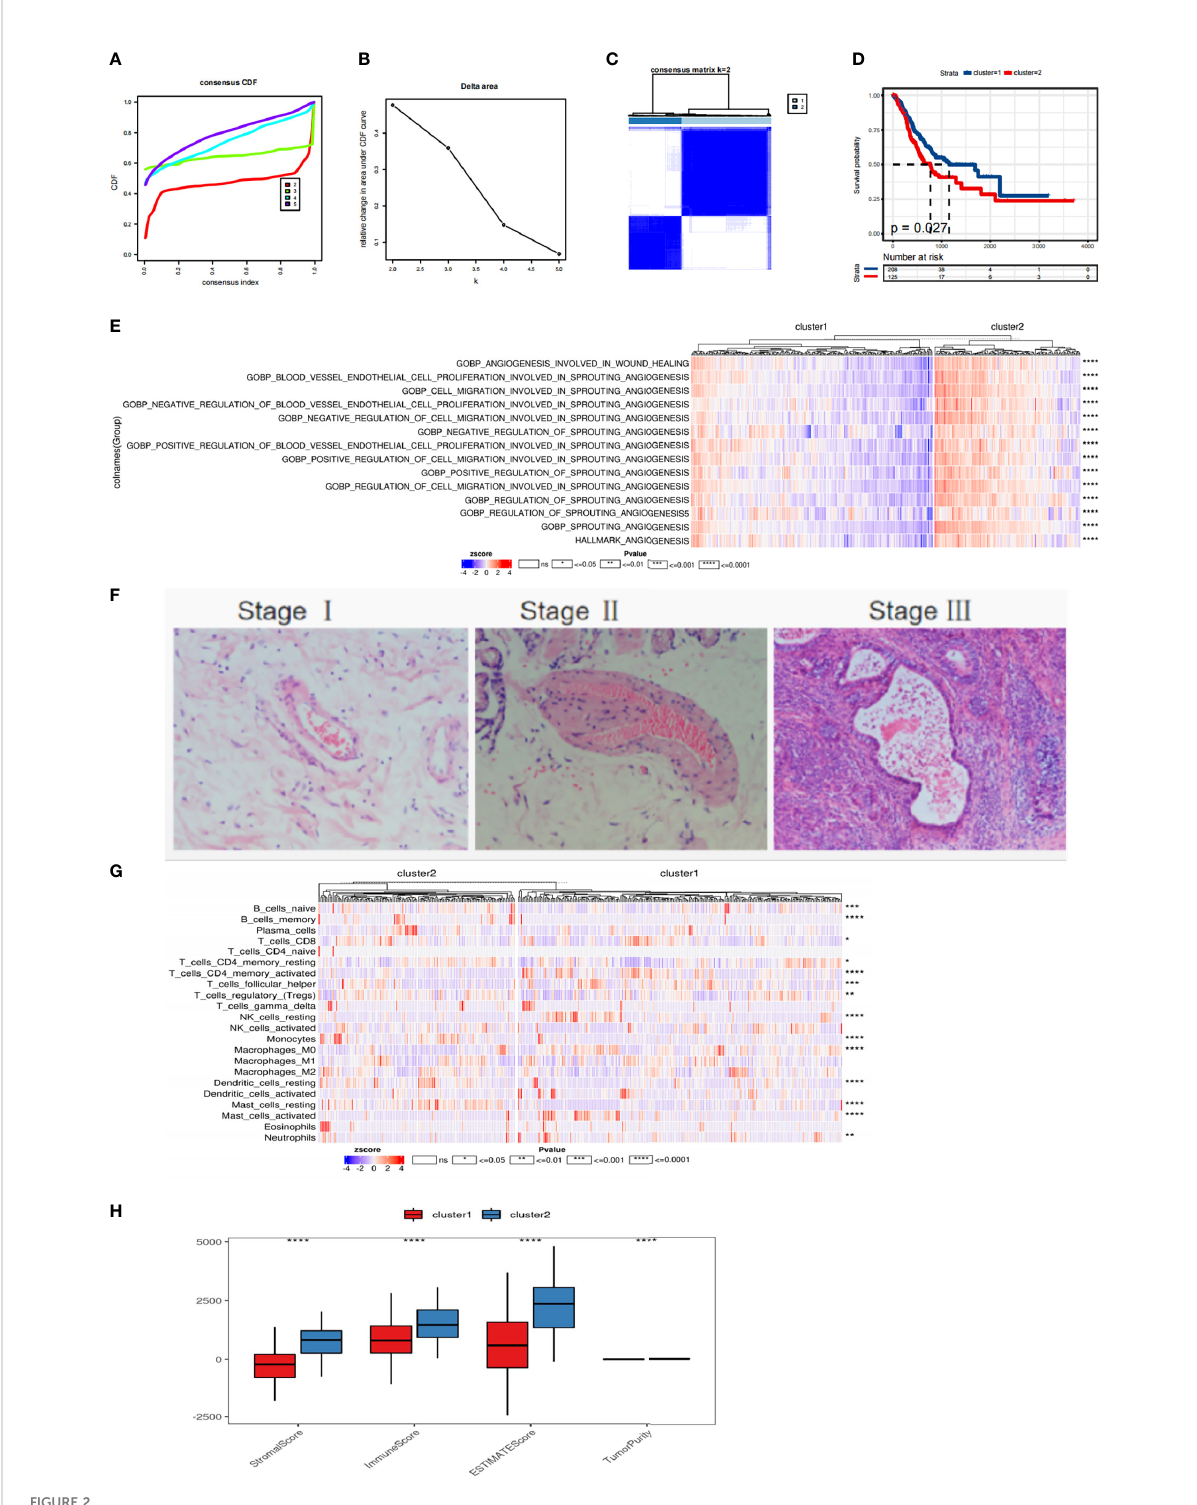
FIGURE 2 Molecular subtype recognition of fatty acid related genes (A, B) TCGA gastric cancer samples were analyzed by consistent cluster analysis based on 78 fatty acid related genes. (C) The consistency matrix heat map when the number of clusters is 2. (D) Survival curve of patients with fatty acid subtypes. (E) The scores of ANGIOGENESIS-related pathways in HALLMARK,GOBP gene set in MSigDB database were calculated by SSGSEA. (F) HE staining of gastric cancer tissue. (G) Using CIBERSORT to calculate the heat map of immune cell in fi ltration. (H) ESTIMATE was used to calculate immune score, matrix score and tumor purity. ns means p > 0.05, *p<=0.05, **p<=0.01, ***p<=0.001 and